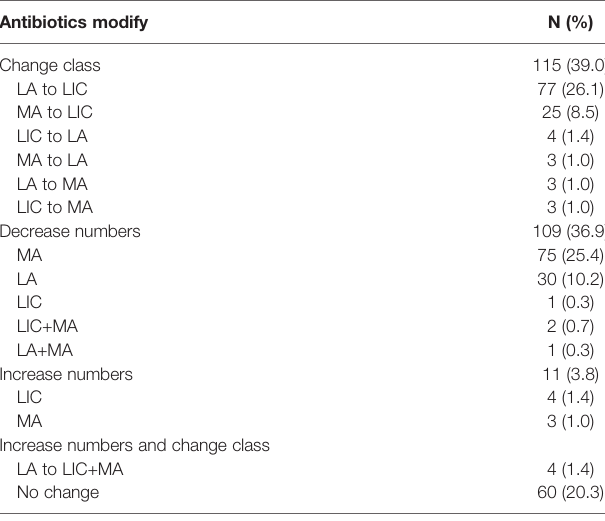
TABLE 4 | Using the results of combined-MS methods to guide the antibiotic treatment (n =